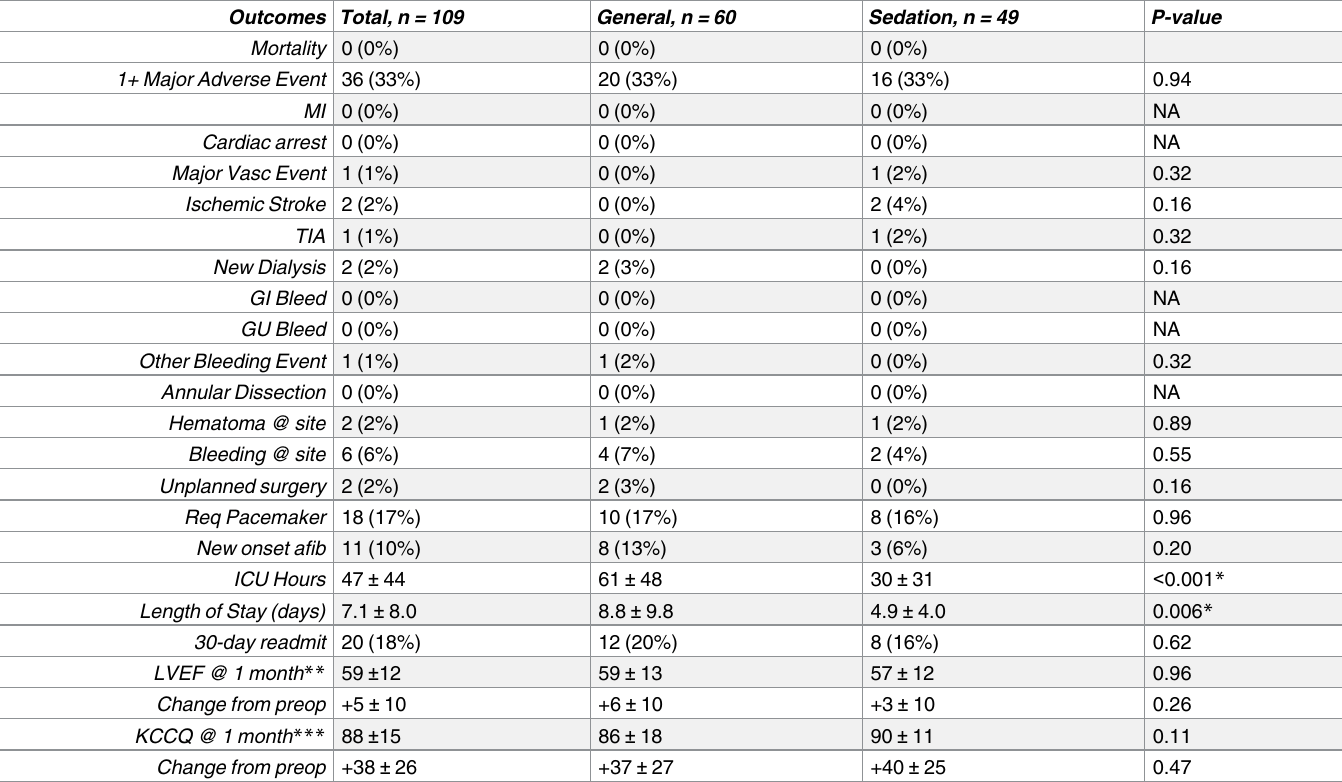
Table 7. Clinical outcomes, excluding Sapien 1 valvesand transapical approach.